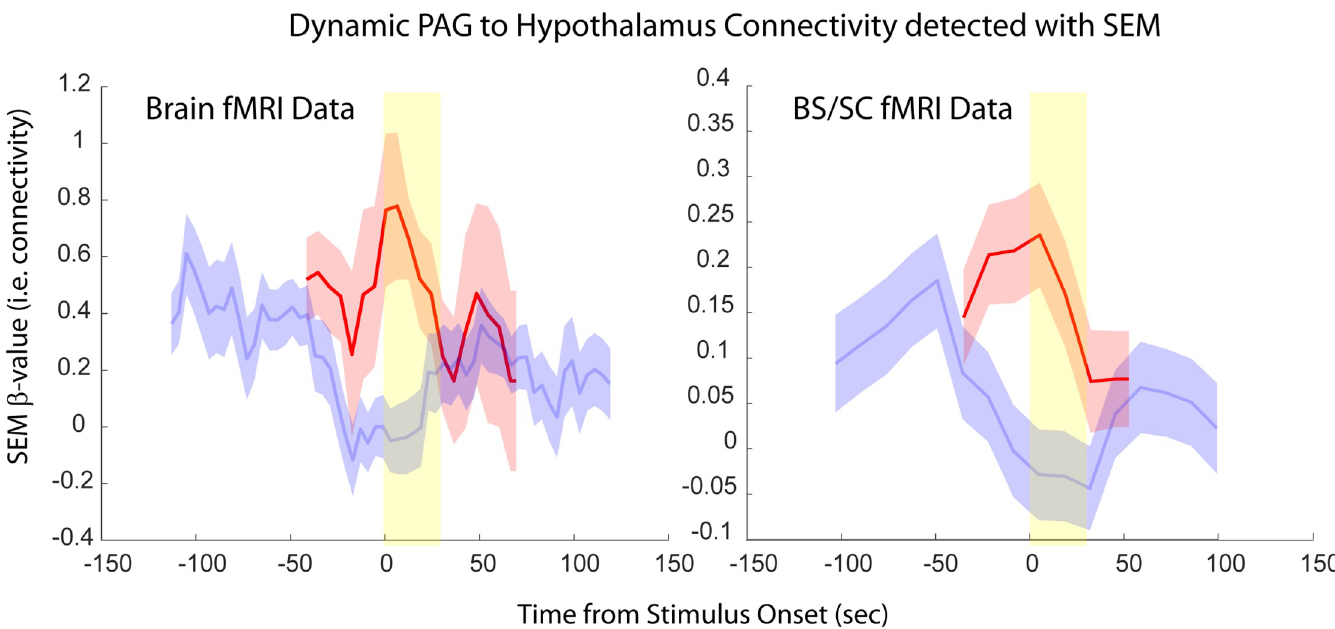
Fig 7. Examples of dynamic variations in the PAG ! Hypothalamus connection, as identified with SEM analysis with 2 sources. Results are shown for data obtained in the brain, and in the BS/SC for Study 1 (red) and Study 2 (blue). The yellow band indicates the stimulation period. The error bars indicate the standard error of the β - values. Similar source and target clusters were selected for the two regions spanned by the data, and the results were within 11.2 mm for the sources, and with 8.7 mm for the